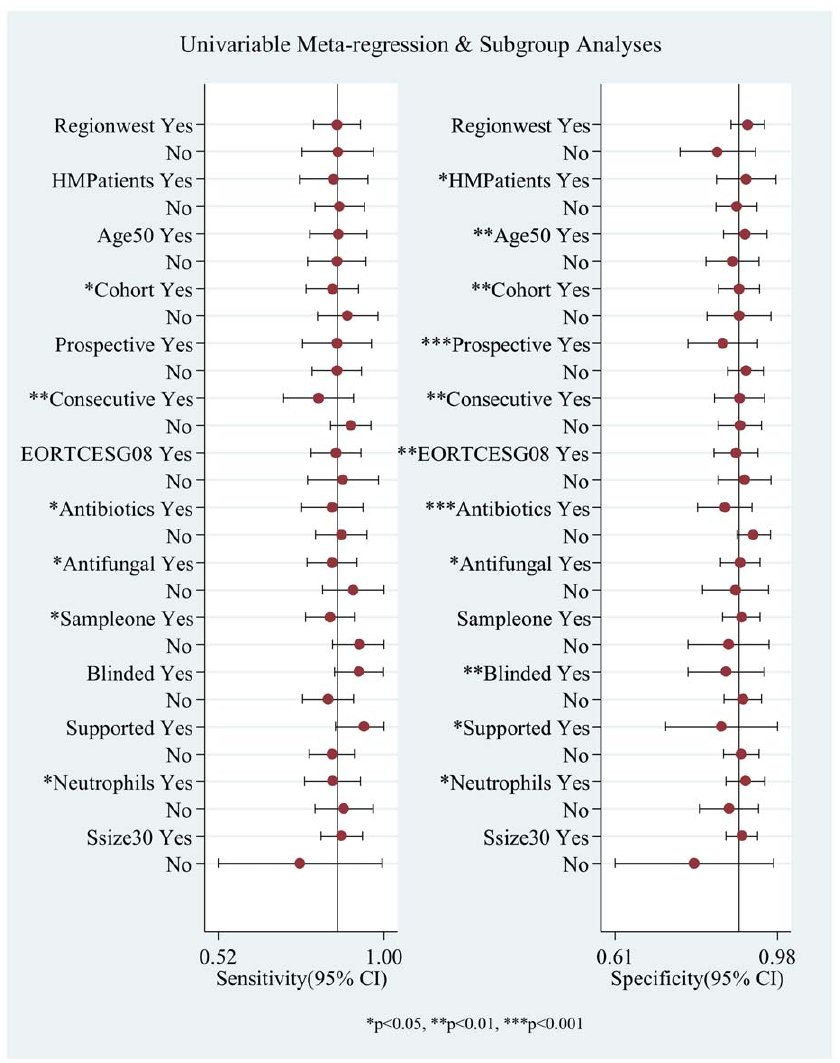
Figure 5. Forest plot of multiple univariable meta-regression and subgroup analyses for SEN and SPE.